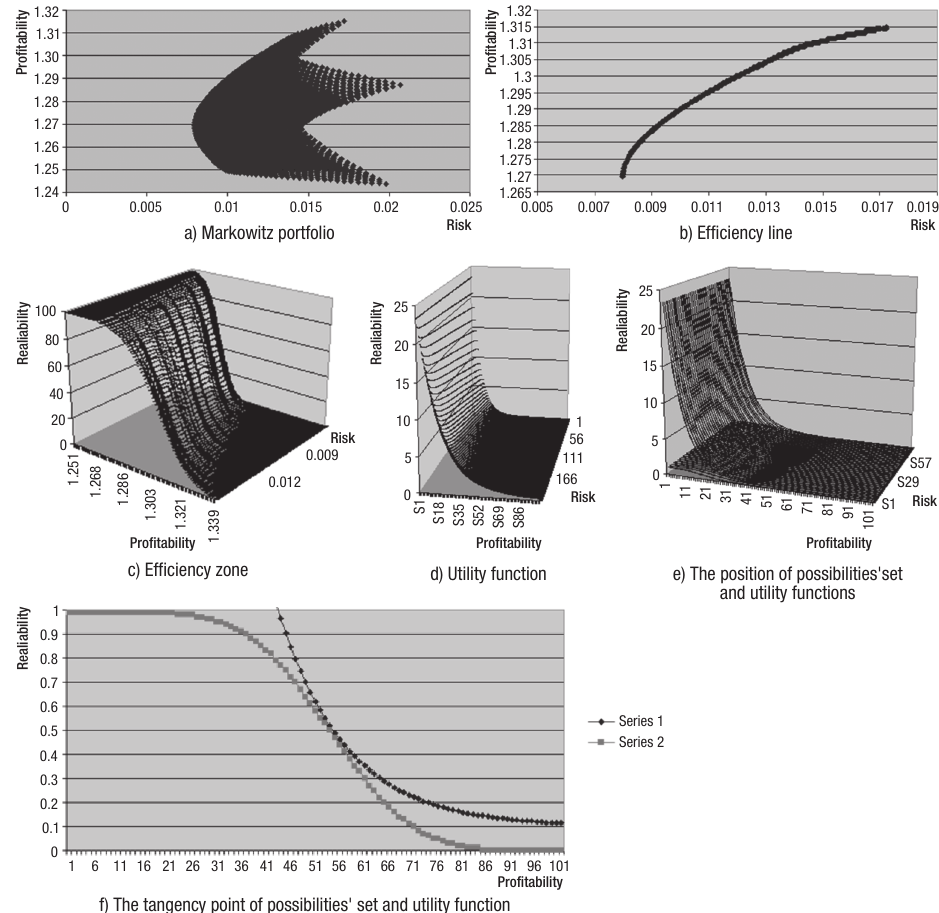
, s ) from Table 2 were i i , s ) i i